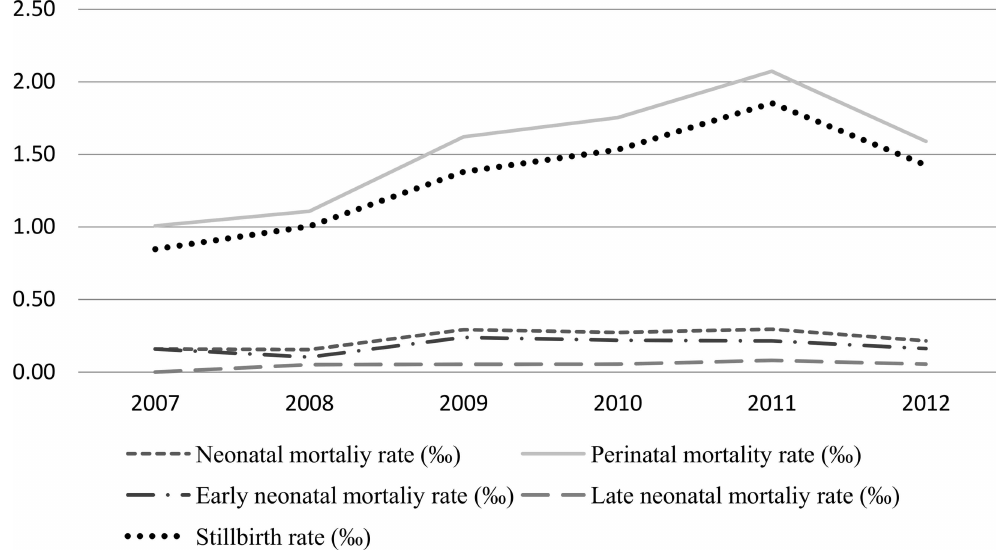
Fig 3. Rates of Stillbirth, Perinatal and Neonatal Mortality of Congenital Syphilis cases from 2007 to 2012. Fortaleza—Ceara´, 2007–2012. Source: Fortaleza Heath Secretary. Mortality Information System (SIM).